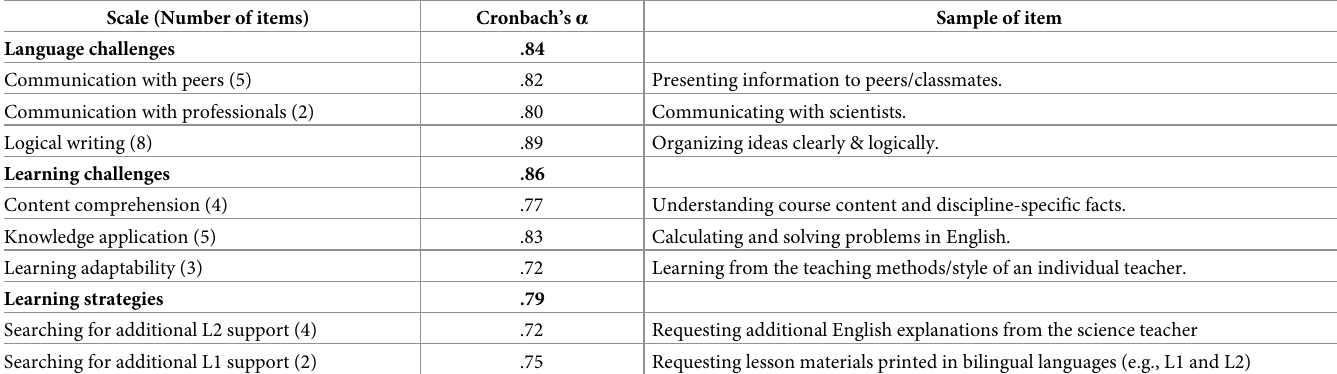
Table 1. The scale components, survey items and their internal